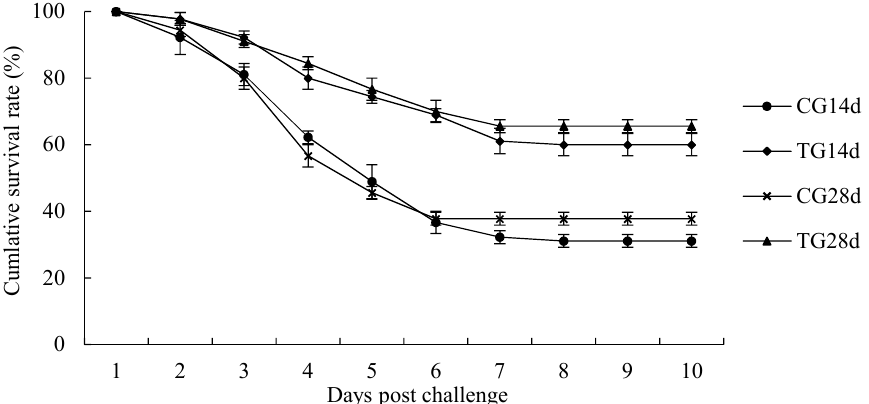
Figure 5. Cumulative survival following a 10-day C. freundii challenge in crayfish. Each value represents the mean ± SD ( n = 3). Different letters were significantly ( p < 0.05) different by LSD test. CG14d, control group after 14 days of feeding; CG28d, control group after 28 days of feeding; TG14d, treatment group ( S. cerevisiae at 10 7 CFU/g diet) after 14 days of feeding; TG28d, treatment group ( S. cerevisiae at 10 7 CFU/g diet) after 28 days of